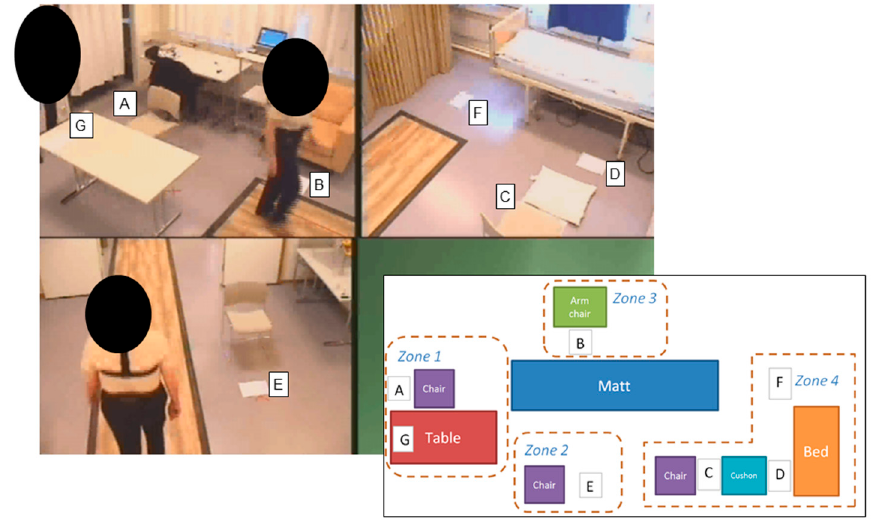
Figure 3. View from the in-lab cameras as a subject performs the semi-structured protocol and the floor plan of the four different activity zones used in the instructions to the participants, represented in Appendix C, Table A3. Table 4. The semi-structured supervised task-based protocol.